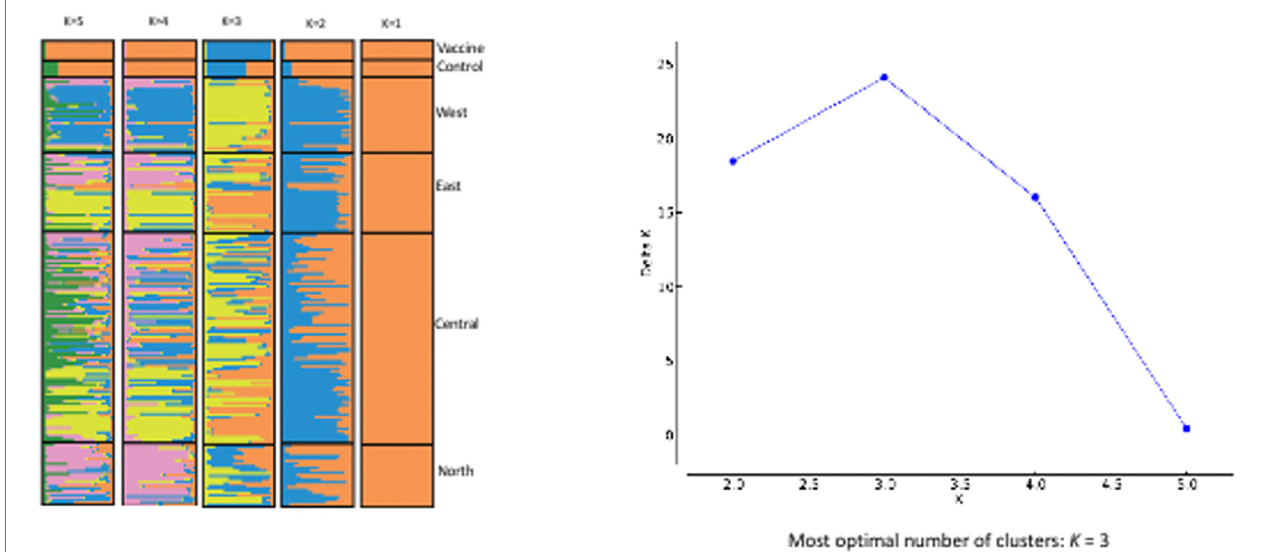
FIGURE 4 | EVANNO Method Delta and STRUCTURE. The graph shows optimal number of clusters from the STRUCTURE analysis; STRUCTURE analysis from K (cid:1) 2 to K (cid:1) 5 with samples from the four regions of Sudan.